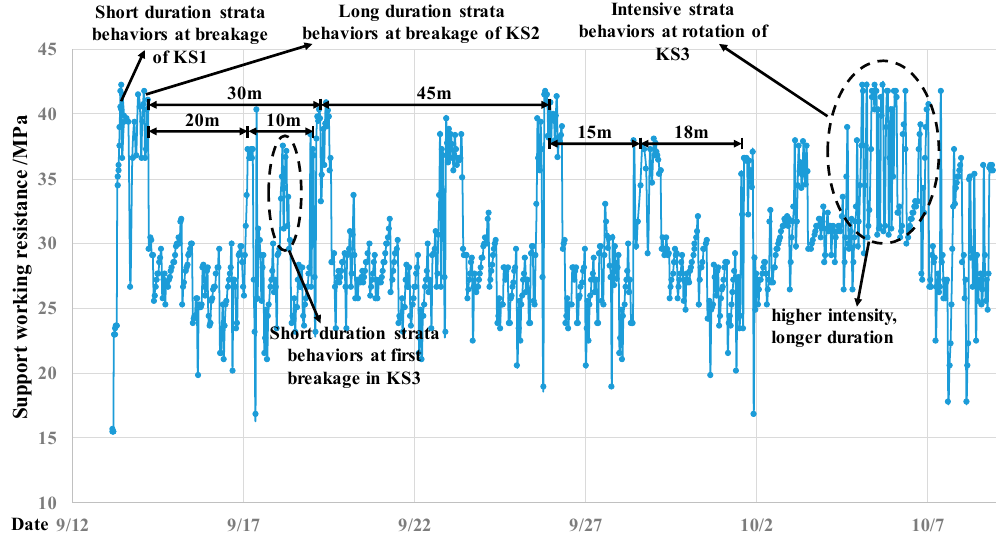
Figure 8. Strata behaviors on supports in the working face.